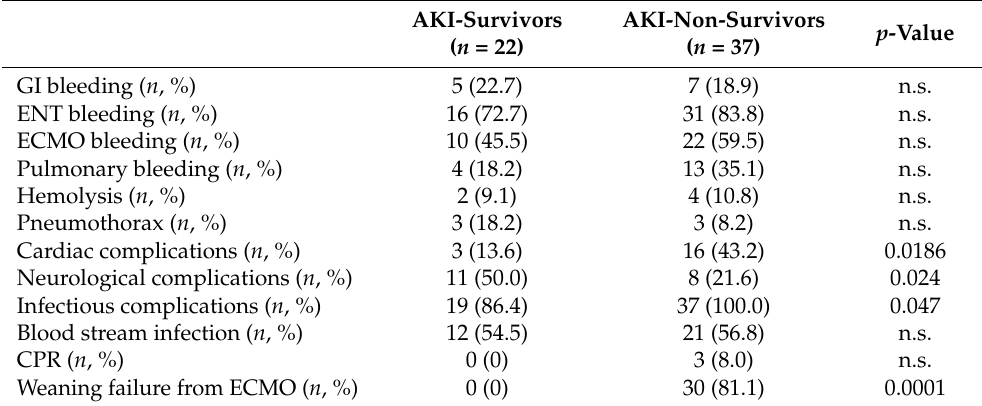
Table 5. The outcomes of patients, comparing AKI-survivors and